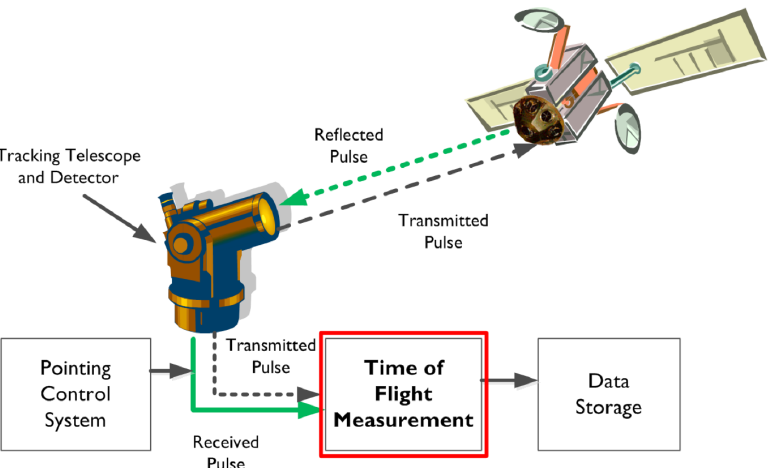
Figure 6. Illustration of the concept of satellite laser ranging (SLR) from Kim et al. (2015) [24] (CC BY-NC 3.0).